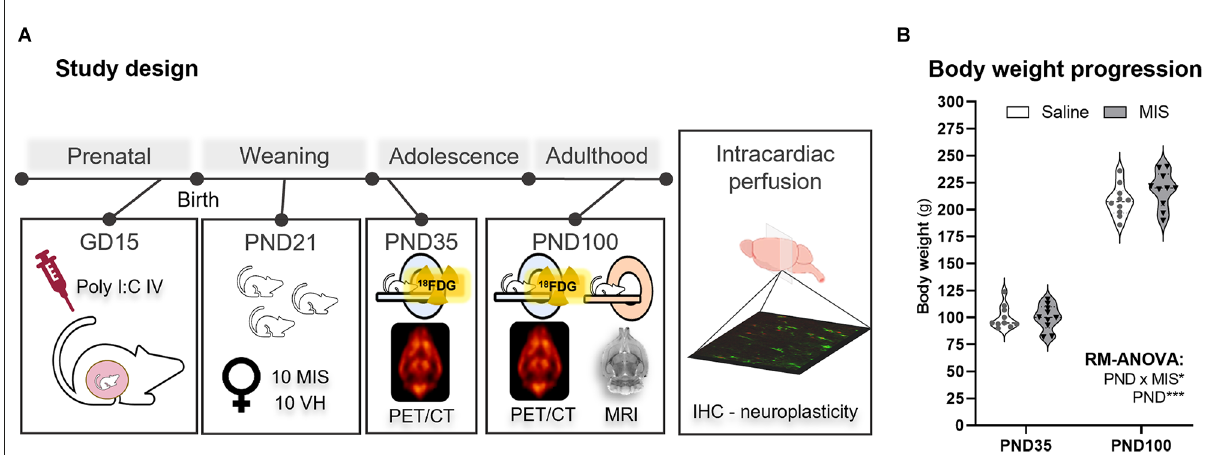
FIGURE1 Study design and body weight changes in adolescence (PND35) and adulthood (PND100). (A) Schematic representation of the experimental procedures according to the age of the animals. (B) Violin plots showing body weight measurements at PND35 and PND100 for the Saline and maternal immune stimulation (MIS) groups. RM ANOVA followed by Bonferroni post-hoc test showed a clear statistically significant difference related to the Age factor (* p < 0.05, *** p < 0.001). The study factors included in this analysis were Age (PND, 35 and 100), and Phenotype (MIS, Saline, and MIS; p <